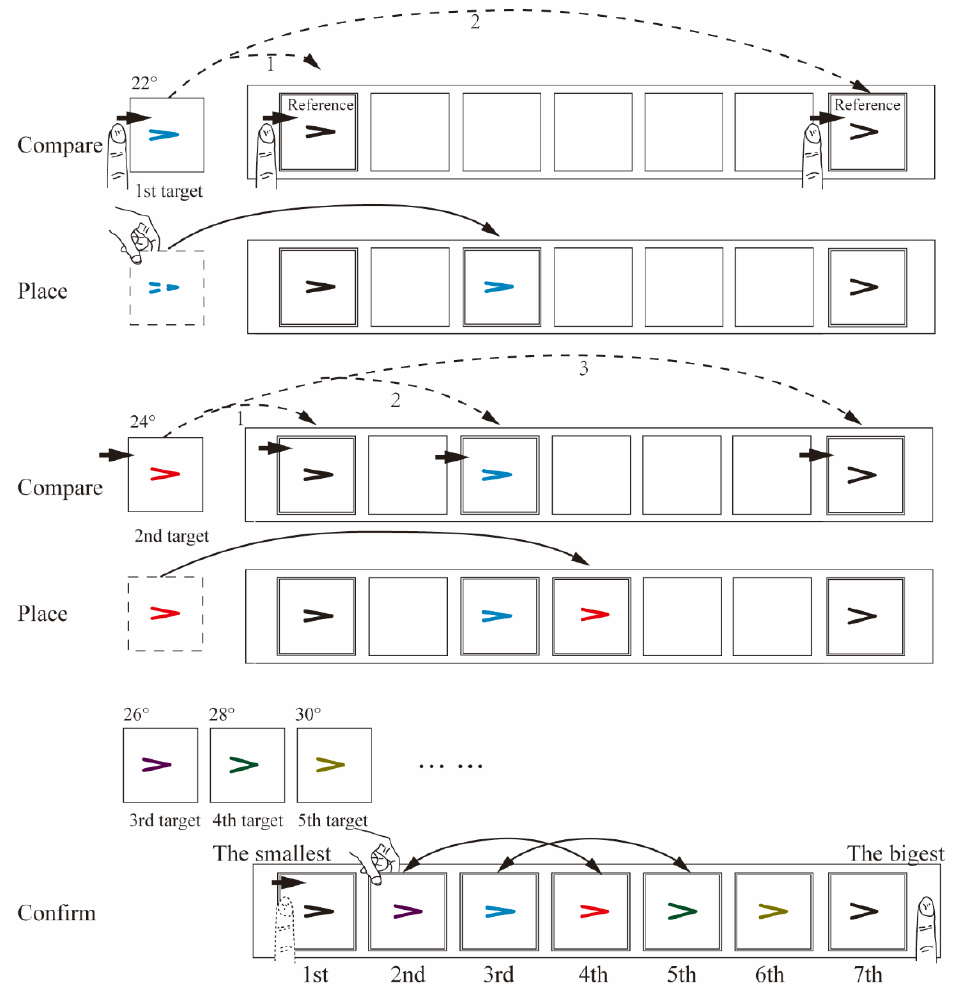
Figure 1. The procedure of a haptic angle sorting paradigm. Each target is randomly selected and submitted to the participant for comparison. After touching the first target, the participant compared it with the reference angle and placed it in a suitable ranking position according to the angle difference. Then, all angles that were placed on the device were used as references to determine the position of the new target. When all five angle stimuli were placed, the participant was required to touch the angle stimuli again from small to large to confirm whether the order was correct. When the participant thought that it was incorrect, he could adjust the sorting as many times as desired. When the participant thought that it was correct, he/she submitted the final result to end the test.